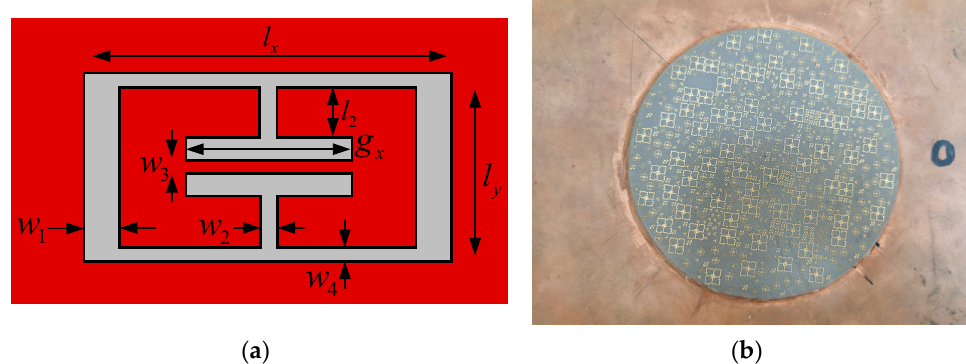
Figure 3. Metamaterial antenna model and physical object. ( a ) Metamaterial antenna model; ( b ) metamaterial antenna physical object. A comparison of the measured radiation pattern of the metamaterial antenna at dif- ferent frequencies is shown in the Figure 4. The radiation pattern characteristics of this transmissive metamaterial antenna were different at individual frequencies.